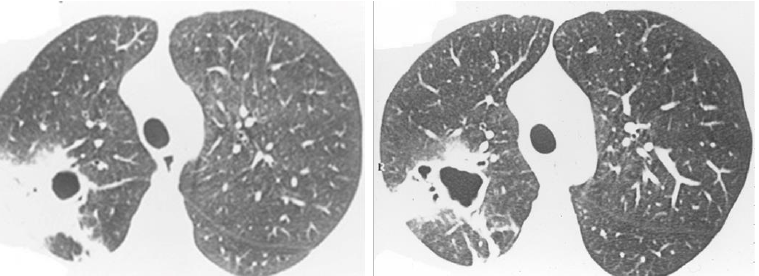
Figure 9. Subacute invasive aspergillosis in a 35-year-old male with HIV infection. CT axial images from an upper and lower levels (left to right) show an irregular cavitary mass in the right upper and lower lobes transgressing the major fissure.